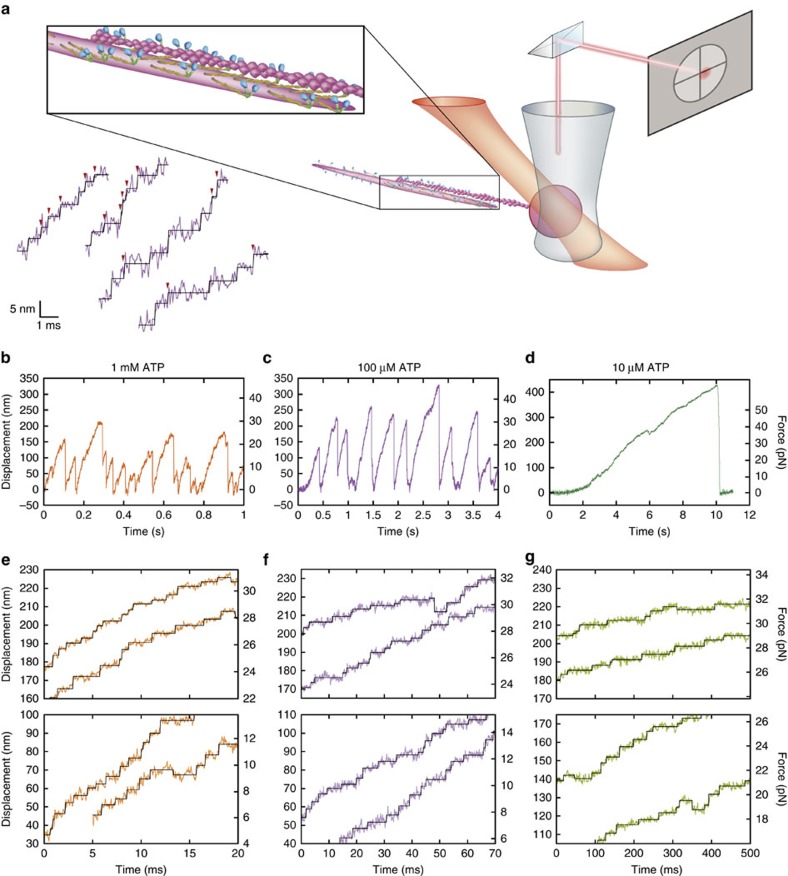
Force generation of myosin-rod cofilaments measured by optical tweezers.(a) Schematic of the optical tweezer assay on a synthetic myosin-rod cofilament interacting with an actin filament. A bead coated with streptavidin is attached to a biotinylated actin filament and held above a myosin-rod cofilament. Scattered images of beads diagonally illuminated by a red laser are projected onto a quadrant photodiode sensor. Inset: measured bead displacements with detected steps (black) reveal stepwise displacements that are frequently generated within 1 ms (red arrowheads). (b–d) Time courses of bead displacement at 1 mM, 100 μM and 10 μM ATP in b–d, respectively. (e–g) Stepwise displacements of actin filaments in response to low loads (bottom panels) and high loads (top panels) at 1 mM, 100 μM and 10 μM ATP in e–g, respectively. The black solid lines represent steps detected by the step-finding algorithm40.